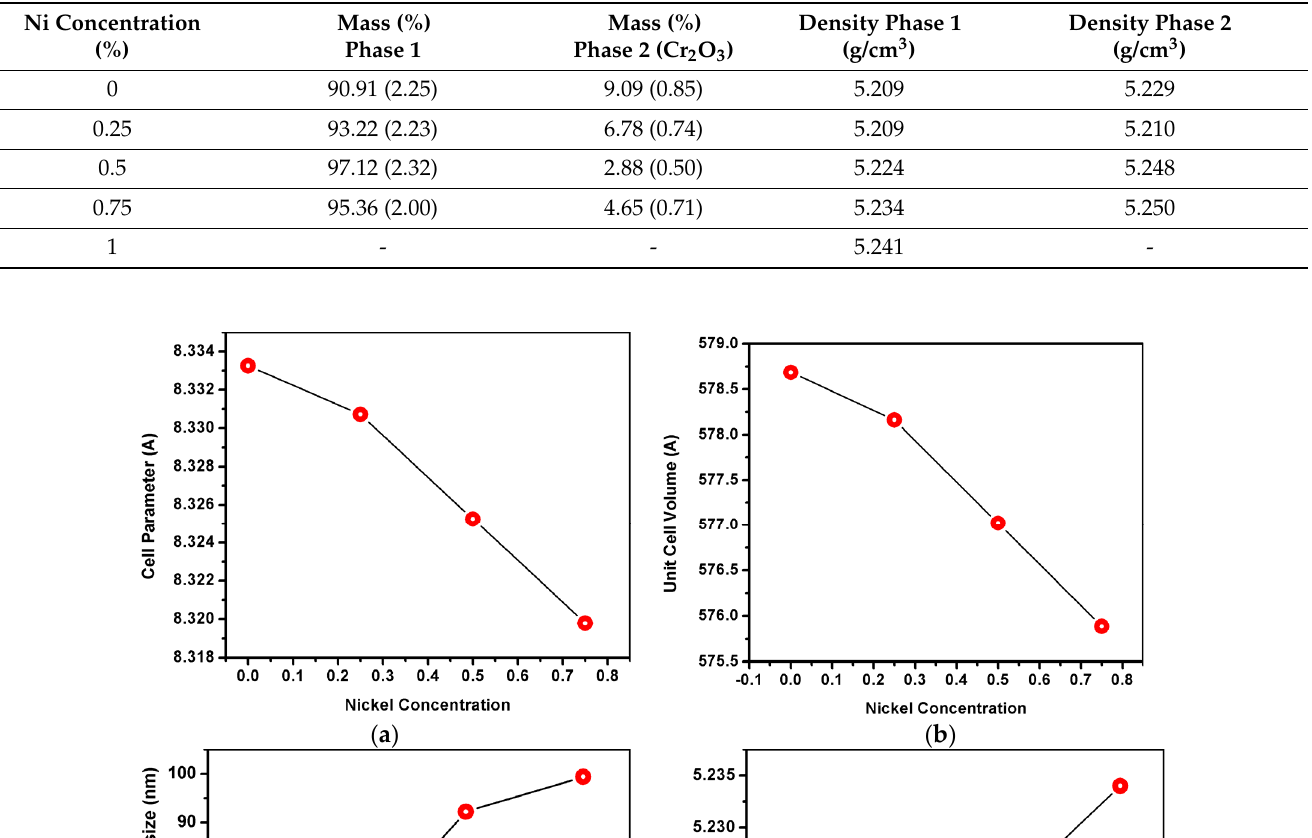
Table 2. Calculated phase distribution.